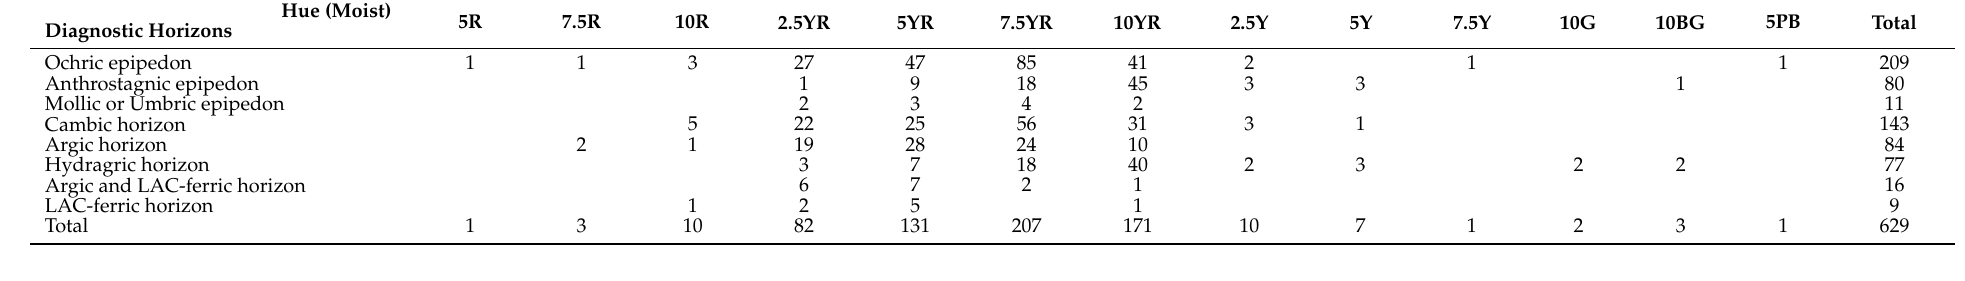
Figure 4. Mean value and standard deviation of soil free iron oxide and SOC content of diagnostic horizons. Table 3. Distribution of hue (moist) of each category of diagnostic horizons.